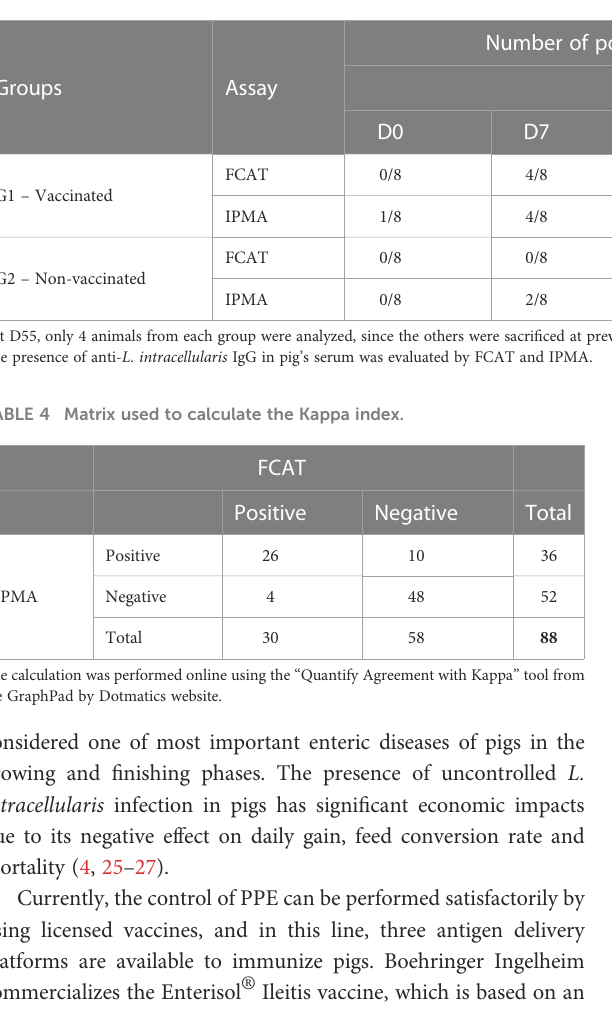
TABLE 3 Serological evolution of pigs immunized or non-immunized pigs with Lawsonia intracellularis .